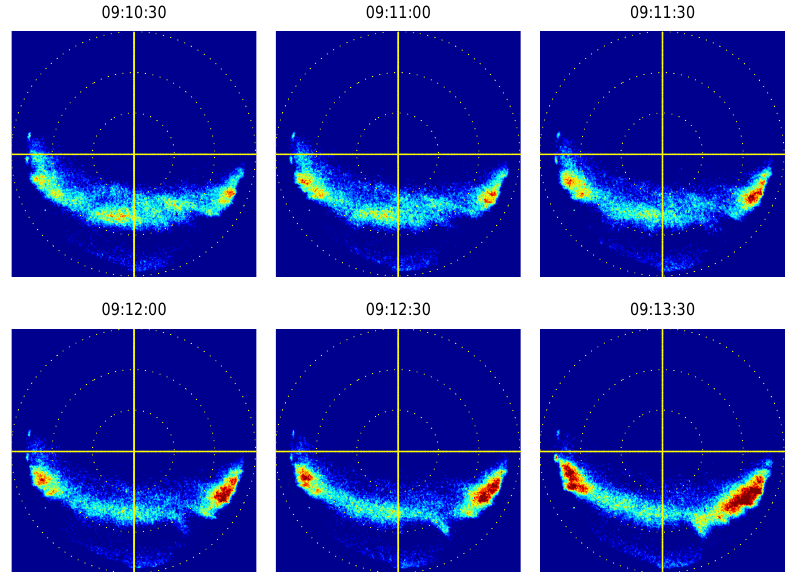
Figure 20 Fig. 20. Ny ˚Alesund ASC observations at 630.0nm for the interval 09:10–09:13 UT on 12 December 1999. Same format as in Fig. 4. The integration time is 2s.